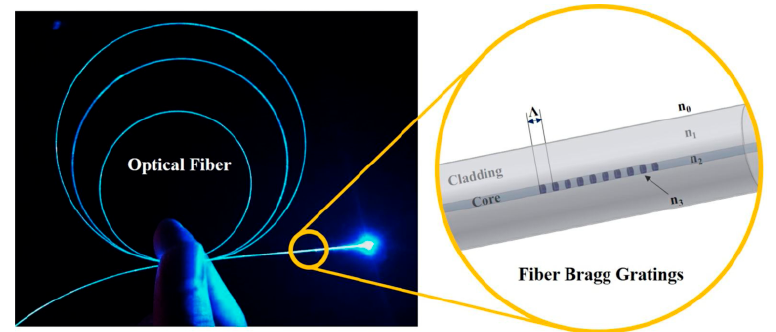
Figure 1. Details of fiber grating coil.